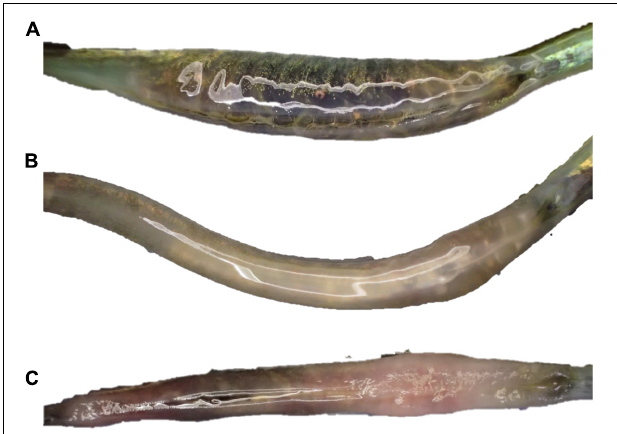
FIGURE 4 | Brood pouch fungus infections were present in 47% of fathers from high origin salinity kept at low acclimation salinity . Pipefish from low origin salinity independent of acclimation salinity and pipefish from high origin salinity kept at high acclimation salinity did not show any signs of fungus infection (A) . In males caught at high origin salinity and kept at low acclimation salinity fungi infections ranged from mild (B) to extreme (C) resulting in the complete loss of eggs and